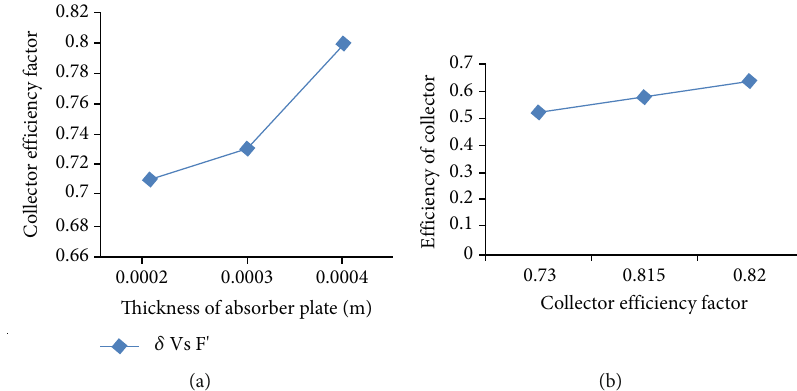
Figure 3: (a) E ff ect of absorber plate thickness on the collector e ffi ciency factor. (b) E ff ect the of collector e ffi ciency factor on collector e ffi ciency